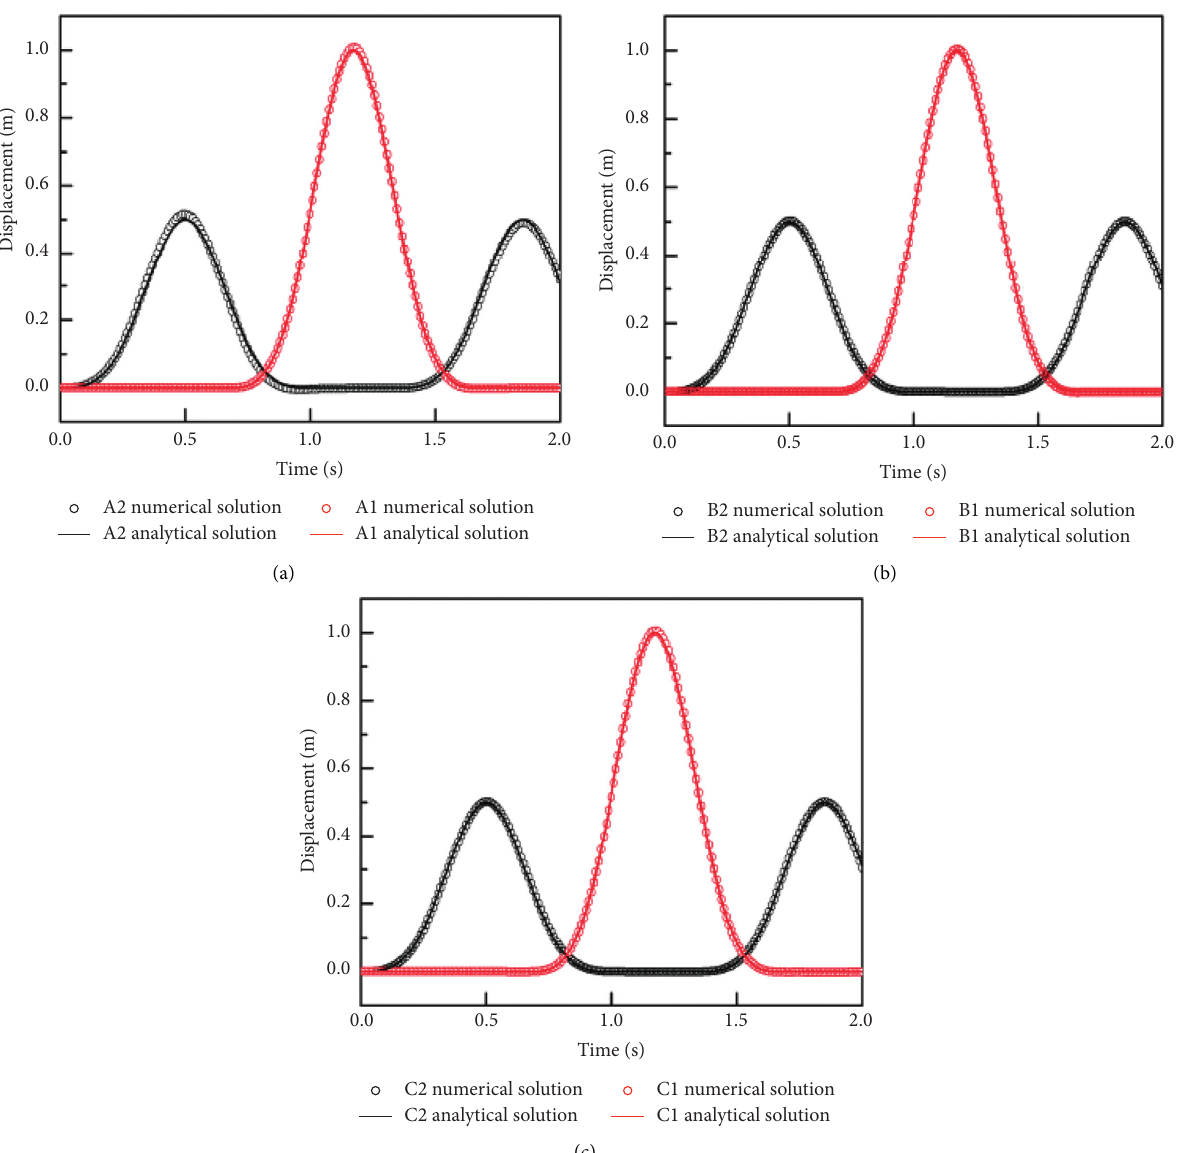
Figure 7: Free-field displacement-time history: (a) observation points A1 and A2; (b) observation points B1 and B2; (c) observation points C1 and